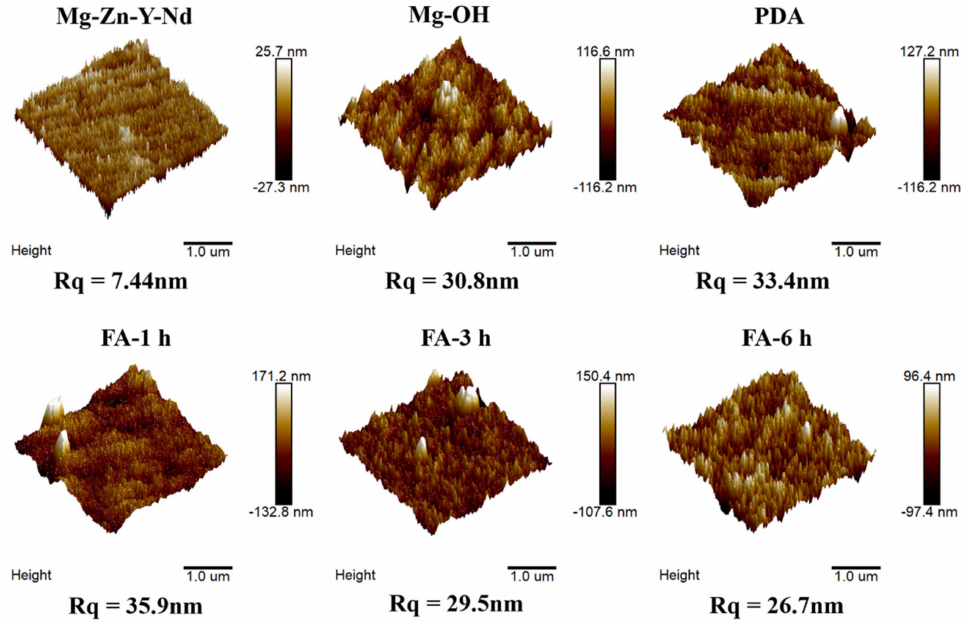
Figure 5. Atomic force topography and roughness of